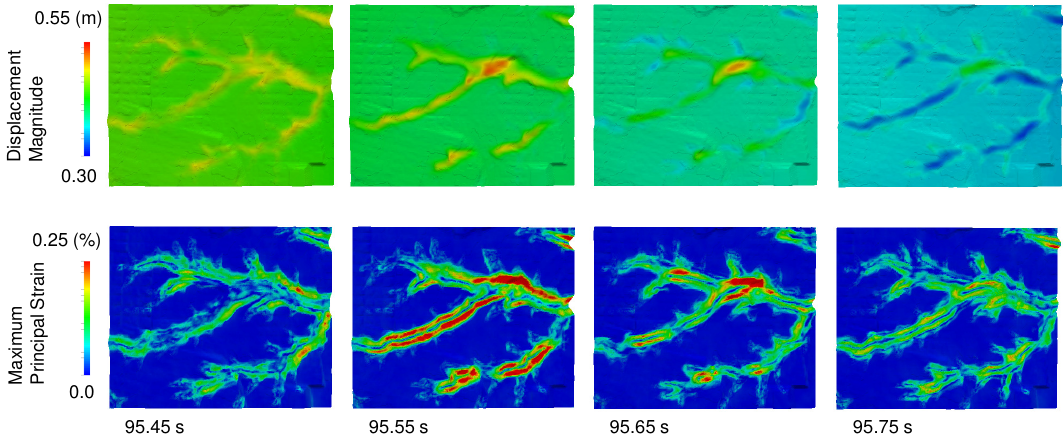
Figure 7. Snapshots of displacement and strain at surface at the center of domain. Displacement is magnified by 200 times for